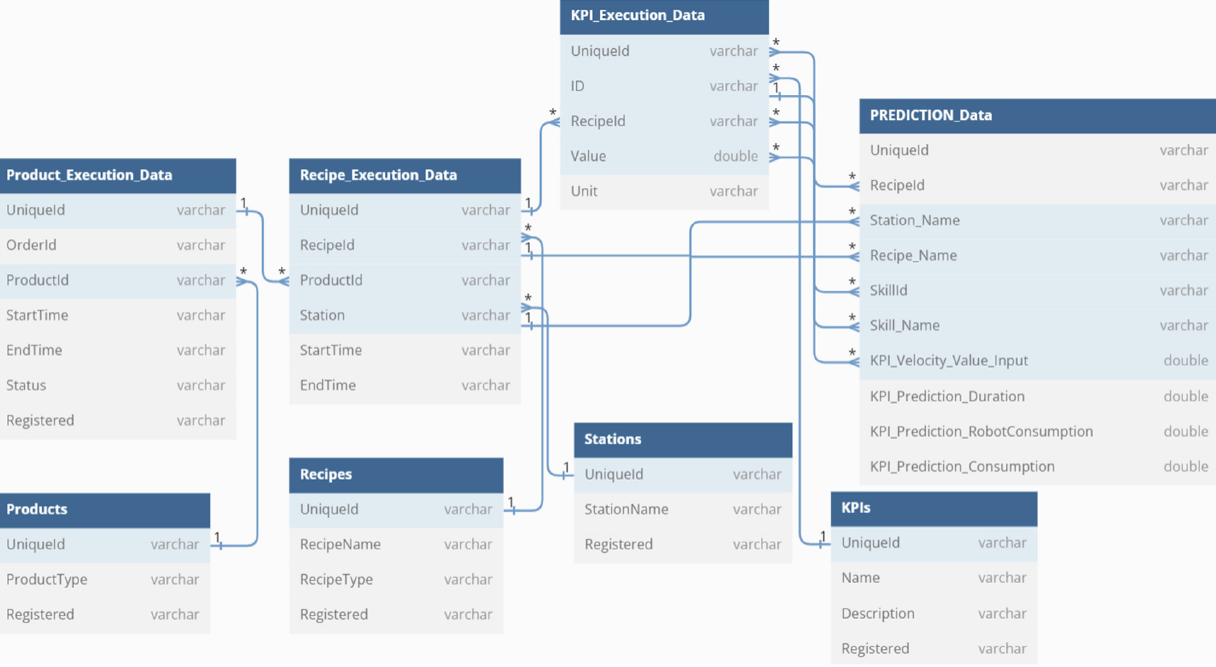
Figure 7. Data model.